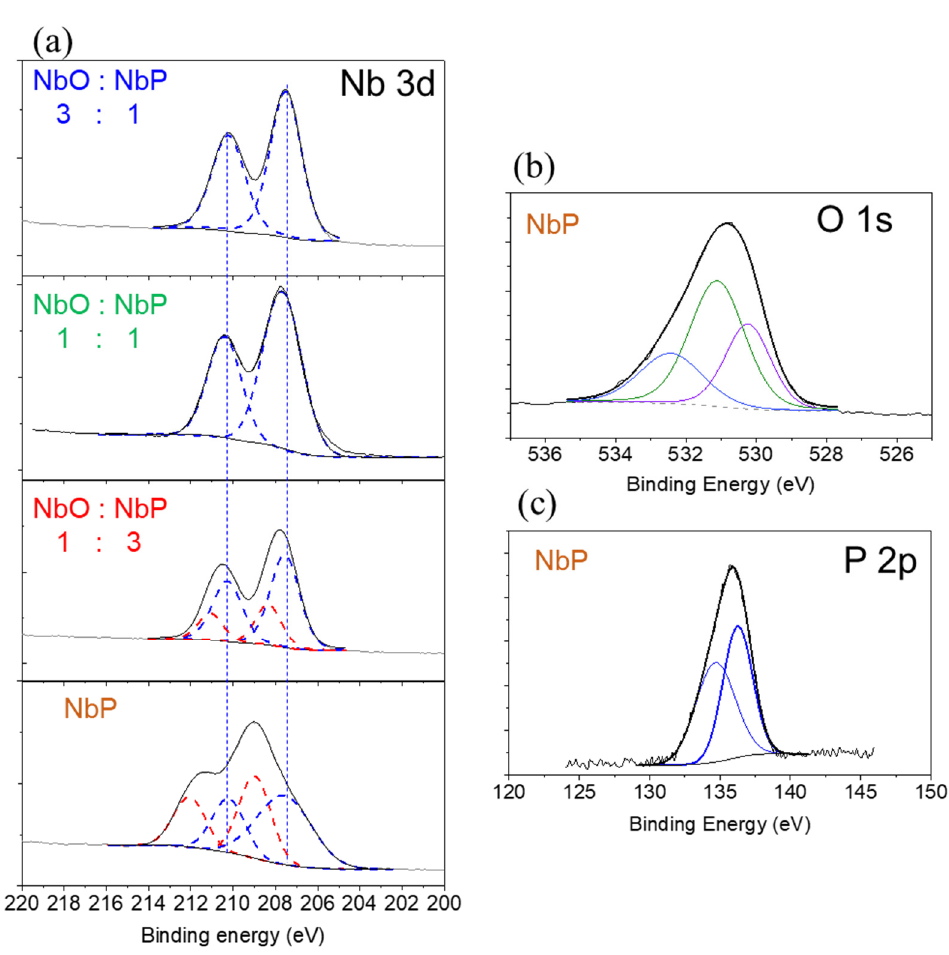
Figure 2. Surface composition analysis by XPS: high resolution spectra of: ( a ) Nb 3d region for NbP and mixtures, ( b ) O 1s region, and ( c ) P 2p region for NbP.